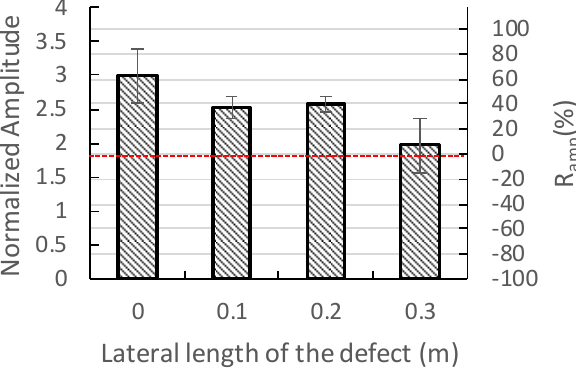
Figure 13. Relationship of the normalized amplitude and the lateral size of the defect for the region containing a 135 ‐ mm CA mortar layer.